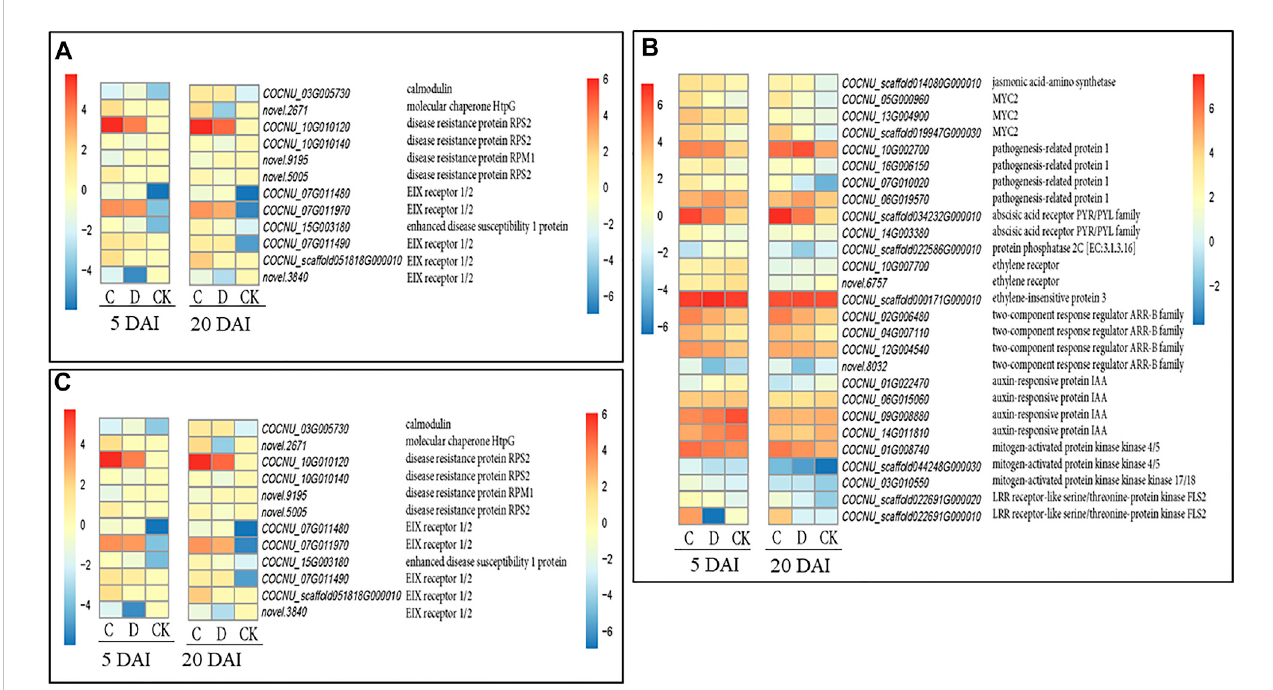
FIGURE 5 Expression pro fi les of potential candidate genes involved in regulating coconut leaf responses to red palm weevil (RPW) attack at 5 and 20 days after infestation (DAI) under three RPW densities (CK = no RPW; C = 15 males and 21 females; D = 20 males and 28 females). Heatmaps were produced with log2transformationoffragmentsperkilobaseoftranscriptpermillionfragmentsmappedvaluesforeachdensity(C,D,andCK)at5and20DAIwith pheatmap package in R (Kolde and Kolde, 2018). (A) . Plant pathogen interaction genes. (B) . Phytohormones and MAPK cascading related genes. (C) . Amino sugar and nucleotide sugar metabolism related genes. The color gradient in the heatmaps for 5 and 20 DAI are shown on the left and right sides, respectively. The FPKM of highlighted genes and several other genes are shown in Supplementary Table